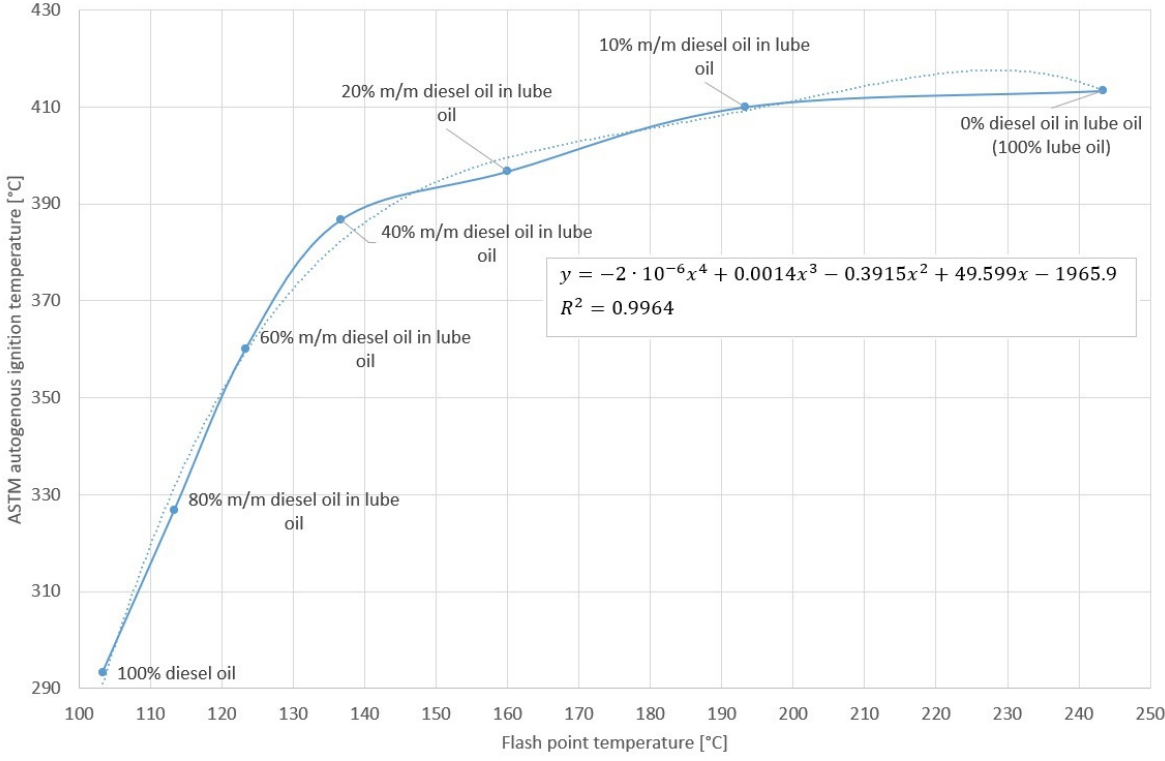
Figure 3. Dependence of autoignition temperature on flash point temperature for engine lubricating oils diluted with diesel fuel in the Ferguson experiment (own work prepared on the basis of [45]); blue dotted line is the trend line described by the function y = f( x ).